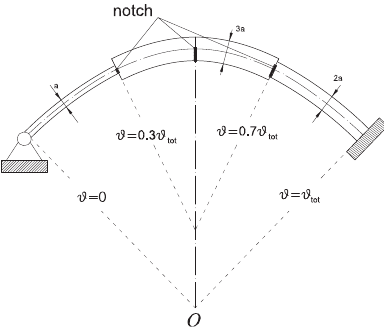
Figure 8: Schematic representation of a Hinged-Clamped three- stepped and multi-damaged parabolic arch.